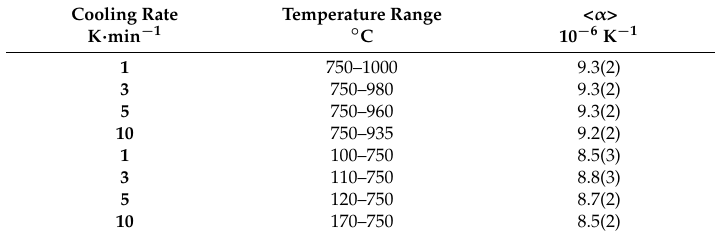
Table 1. The mean thermal expansion coefficients, < α >, determined for BZCY72 in dry